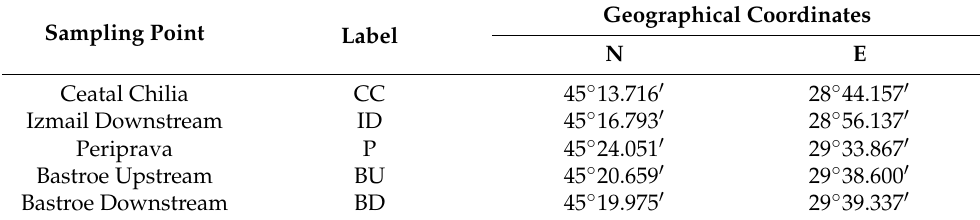
Table 1. Geographical coordinates of sampling points from Chilia branch.